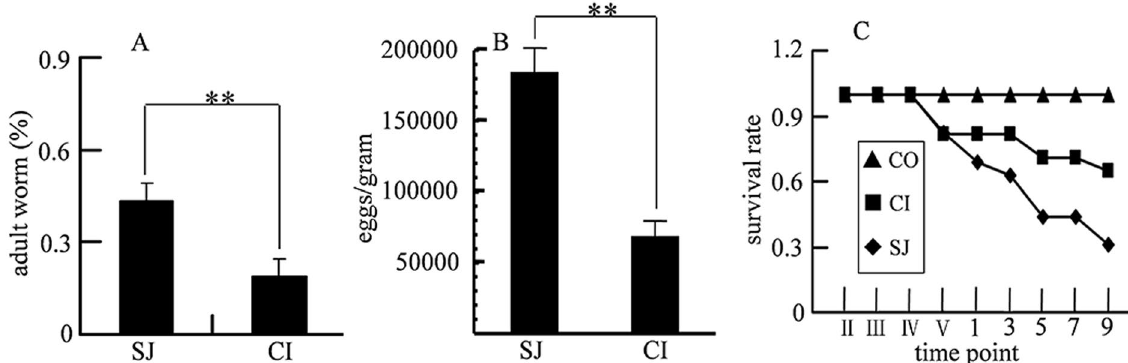
Figure 1. Worm burden, liver egg burden and animal survival rate. ( A ) Adult worm of S. japonicum obtained from mice infected with S. japonicum (SJ) and those coinfected with S. japonicum and S. typhimurium (CI); ( B ) S. japonicum eggs obtained from liver of mice infected with S. japonicum (SJ) and those coinfected with S. japonicum and S. typhimurium (CI); ( C ) Survival rate of mice in different groups. SJ, mice infected with 80 cercariae of S. japonicum only; CI, mice infected with 80 cercariae followed by S. typhimurium ATCC14028 infection 5 weeks later; CO, mice as uninfected control. Time points in Roman numerical mean corresponding weekly points, time points in Arabic numerical indicates days after S. typhimurium was introduced. The statistically significant differences were calculated using independent samples T test with SPSS 13.0 and error bars represent SEM, ** p <